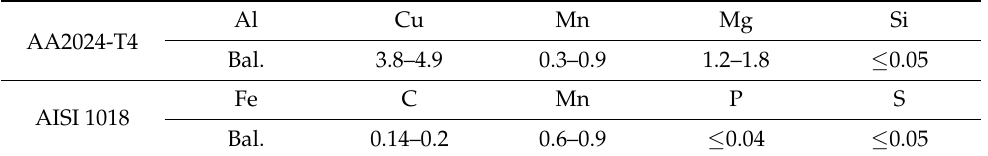
Table 1. Nominal chemical compositions (in wt.%) of AA2024-T4 and AISI 1018 base materials, data from [37].